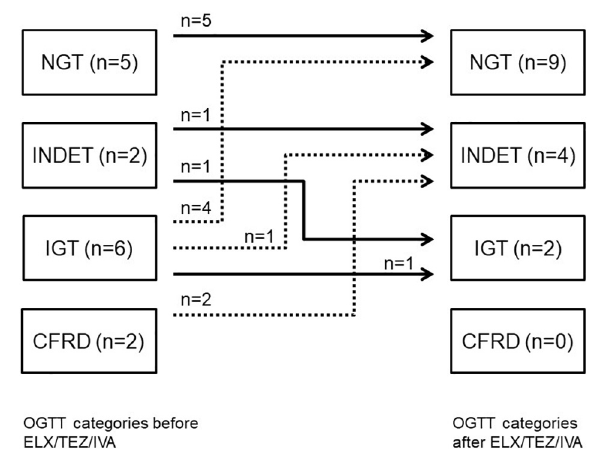
FIGURE 2 | OGTT categories before and after starting ELX/TEZ/IVA treatment in people with cystic fibrosis. Numbers of study participants and OGTT categories and individual changes after starting ELX/TEZ/IVA treatment. OGTT, oral glucose tolerance test; NGT, normal glucose tolerance; INDET, indeterminate glucose tolerance; IFG, impaired fasting glucose; IGT, impaired glucose tolerance; CFRD, CF-related